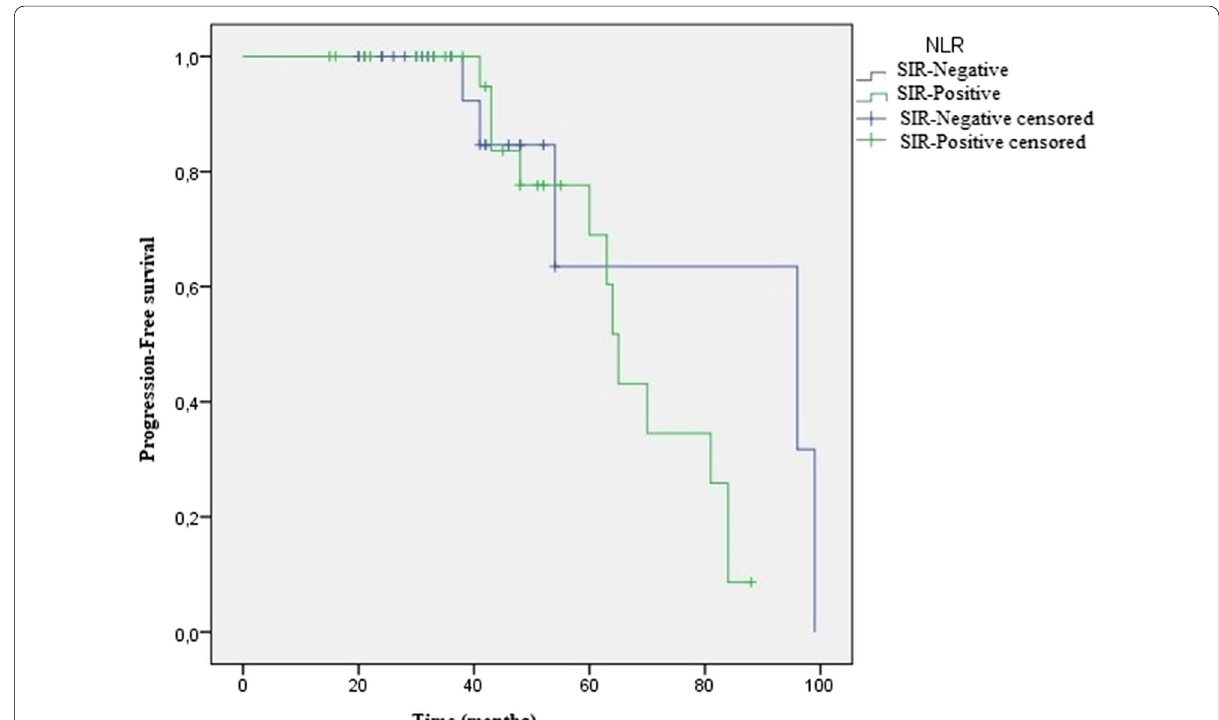
Fig. 2 Neutrophil/lymphocyte ratio (NLR)–progression-free survival: SIR (systemic inflammatory response)—negative, SIR (systemic inflammatory response)—positive